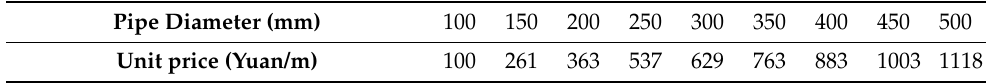
Table 1. Unit price of a ductile iron pipe.